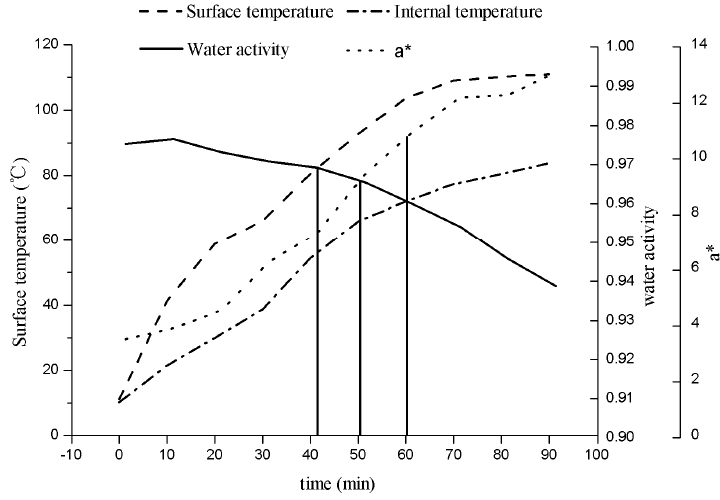
Figure 3. Alteration of the temperatures, water activity and red colour during drying.